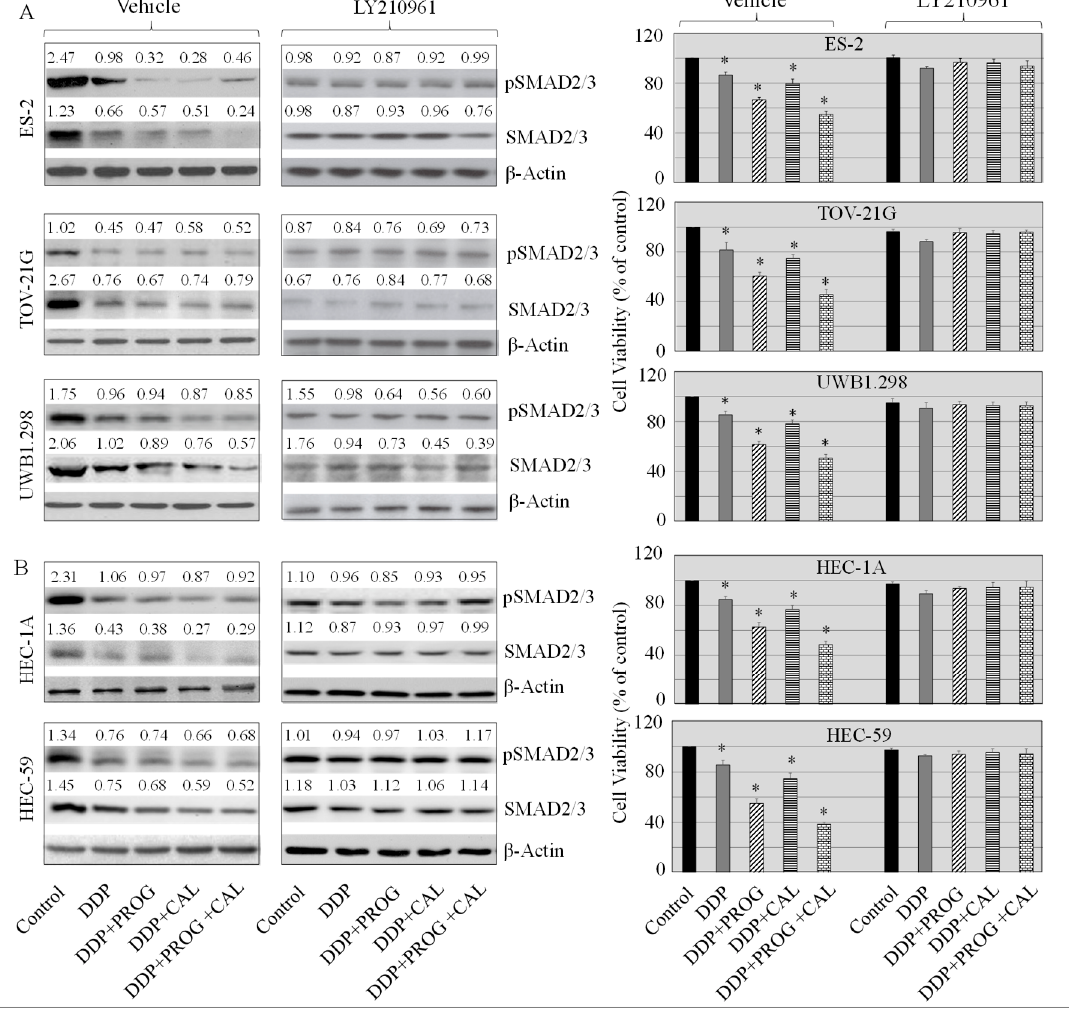
Figure 6. Progesterone-calcitriol combination enhanced the inhibitory effect of DDP by suppressing the expression of SMAD2/3 in cancer cells. The cancer cells were treated with DDP (6 μ M), progesterone (20 μ M), calcitriol (30 nM) and progesterone-calcitriol combination for 72 h in the presence or absence of TGF β R1 blocker (LY210961, 10 μ M). The effect of treatment on SMAD2/3 expression ( A ) and cell viability ( B ) was assessed using Western blotting and MTS assay respectively. β -actin was used as a loading control. The values above the bands represent the relative density of the bands normalized to β -actin. Data is the mean ±SEM of triplicates: an asterisk * indicated p < 0.05 (statistically significant) between the control and the treatment groups. The experiment shown is representative of at least three experiments, all with similar results.